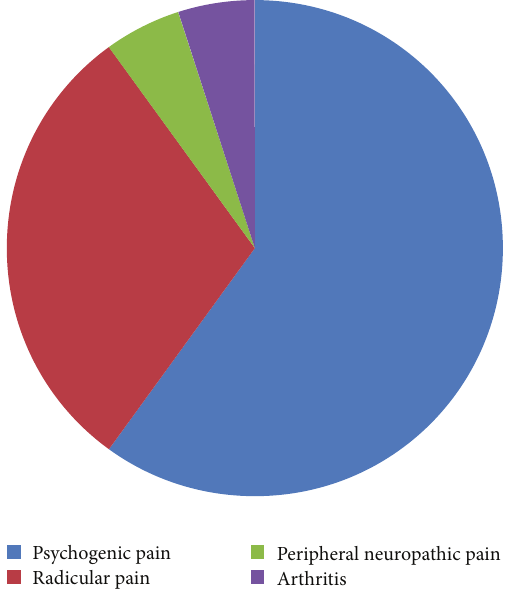
Figure 2: Category of non-PD-related